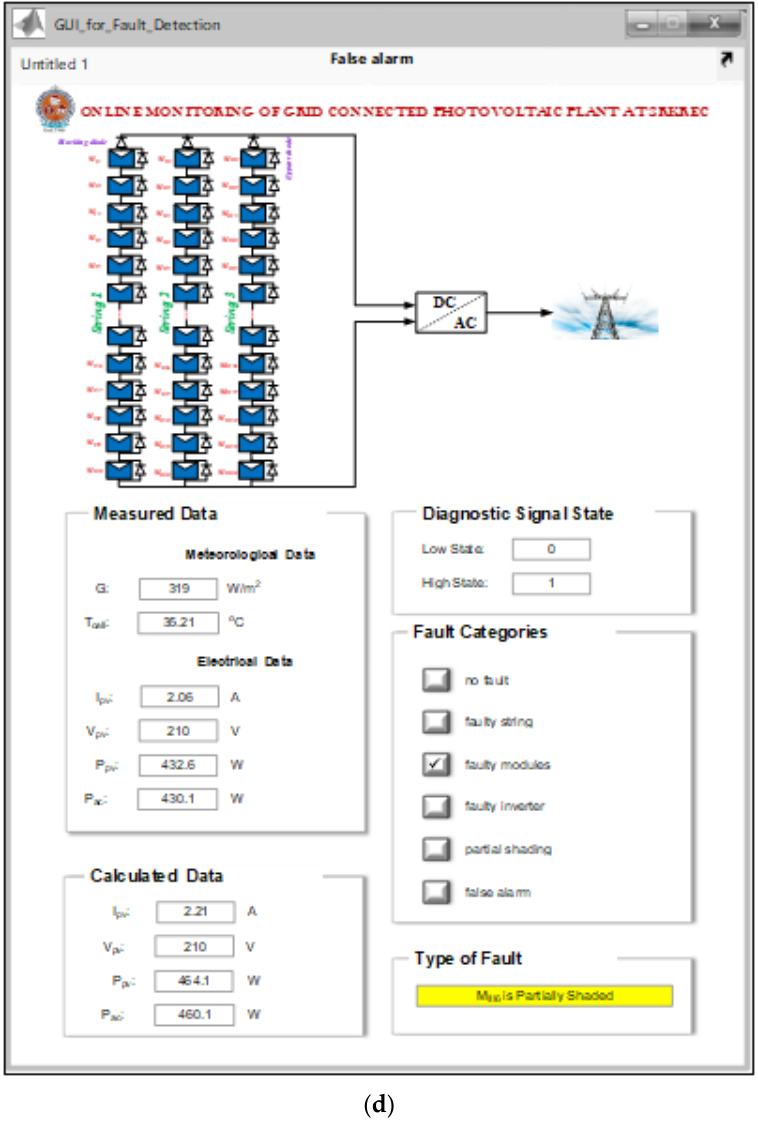
Figure 15. ( a ) Evolution of diagnostic signal during inverted bypass fault condition; ( b ) measured PV current; ( c ) measured PV current; ( d ) faulty module observed in designed tool.